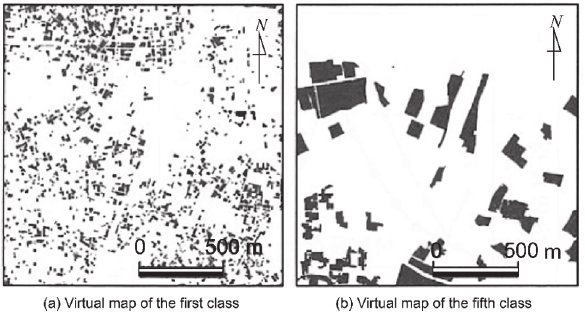
Figure 8 . Shape differences of classes having the same area.